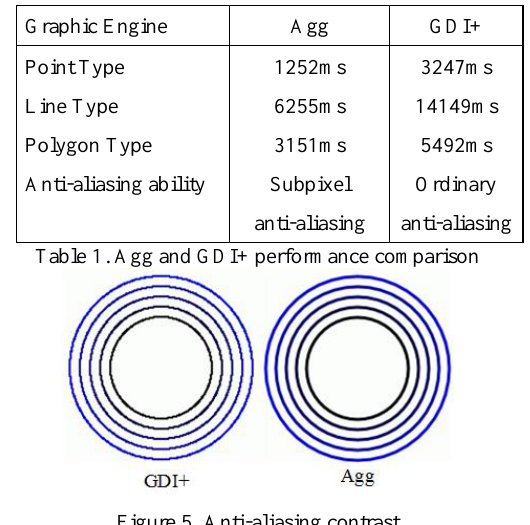
Figure 5. Anti-aliasing contrast